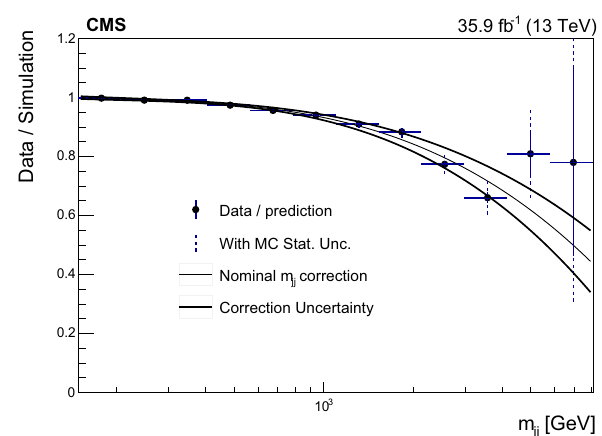
Fig. 3 Data divided by simulation as a function of ln ( m jj / GeV ) in a signal-depleted control sample with R ( p T ) > 0 . 2. This distribution is fit by a third-order polynomial (solid black line) in order to derive a correction on the simulation m jj prediction. The points are varied by the uncertainty, including the effect of the limited number of simulated events and refitted in order to derive the systematic variations on the correction (dashed lines) corresponding to a standard deviation